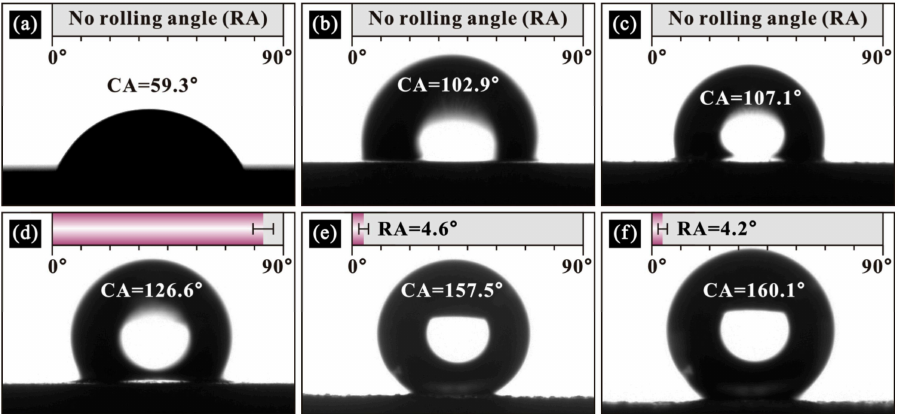
Figure 9. Wetting characteristics on modified 7075 aluminum alloys with different etching time: ( a ) 0 min, ( b ) 1 min, ( c ) 3 min, ( d ) 5 min, ( e ) 7 min and ( f ) 9